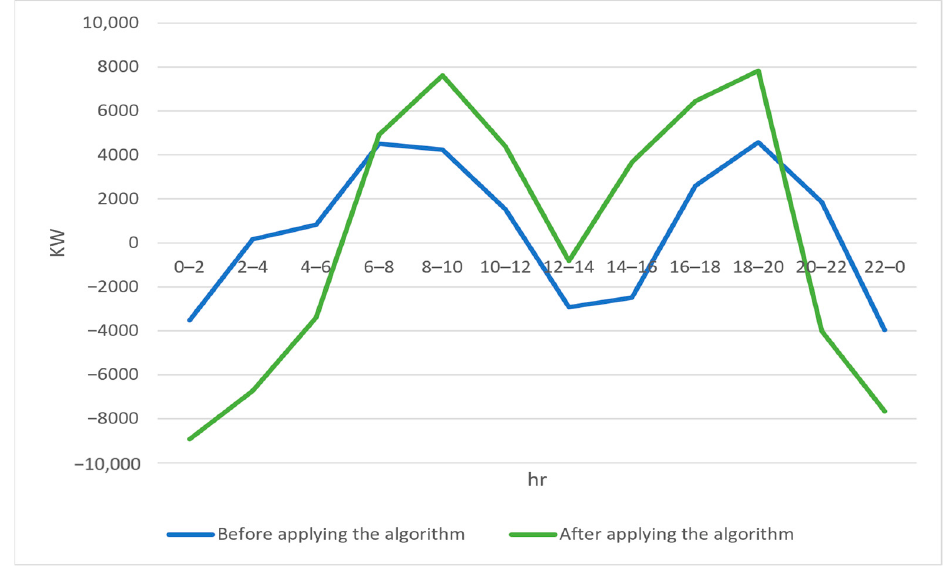
Figure 10. Comparison of charging/discharging pro fi les for the EV ba tt eries.